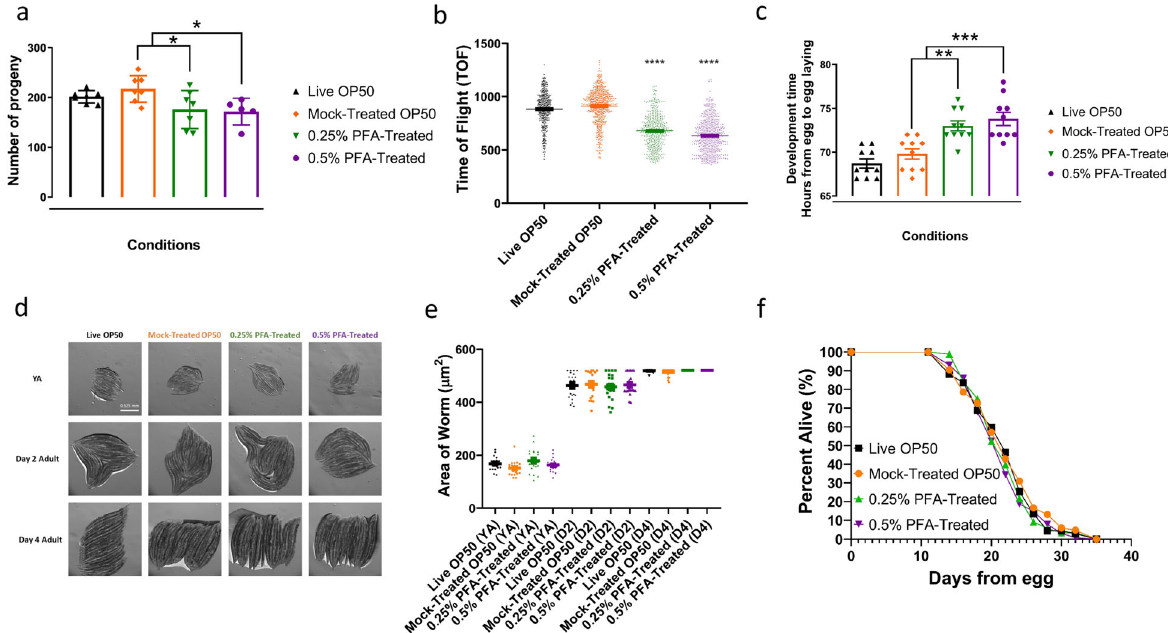
Fig. 5 The effects of paraformaldehyde killed OP50 on fecundity, development, and lifespan. a Average progeny number of worms fed with different bacteria conditions. b Development of worms sorted based on relative axial length (Time of fl ight, TOF) at L4. c Development time (hours) of worms from egg to egg laying on different conditions of OP50. d Images of worms on various food sources at young adult (YA), day 2, and day 4 adult. e Area of the worms ( µ m 2 ) quanti fi ed from images in Fig. 5d. f Percent alive of worms fed with treated and control OP50. Single asterisk denotes p -value < 0.05, double asterisks denote p -value < 0.005, triple asterisks denote p -value < 0.0005, and quadruple asterisks denote p -value < 0.0001.